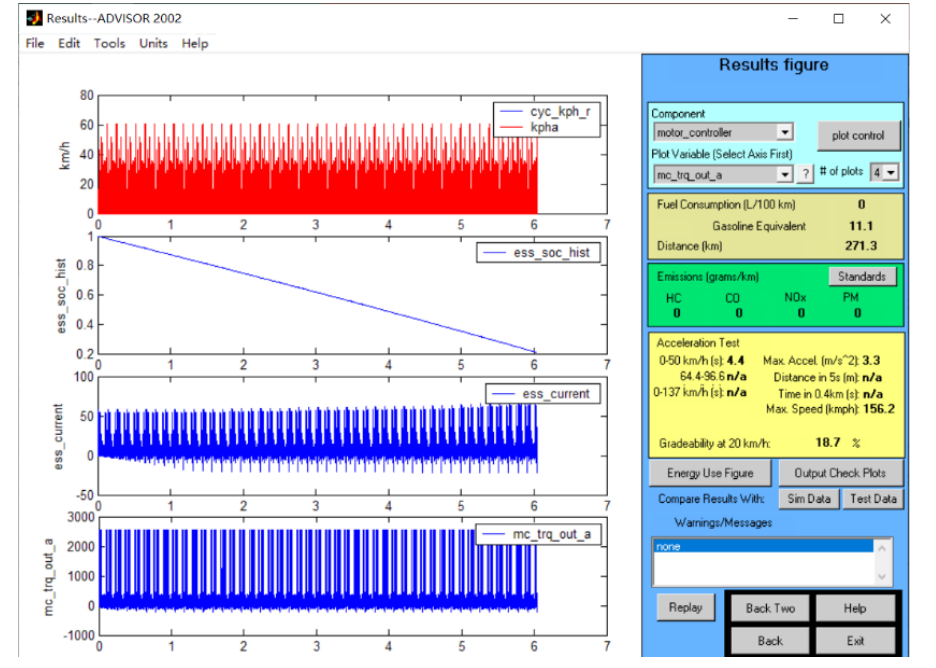
Figure 13. Simulation results of experiment 5.